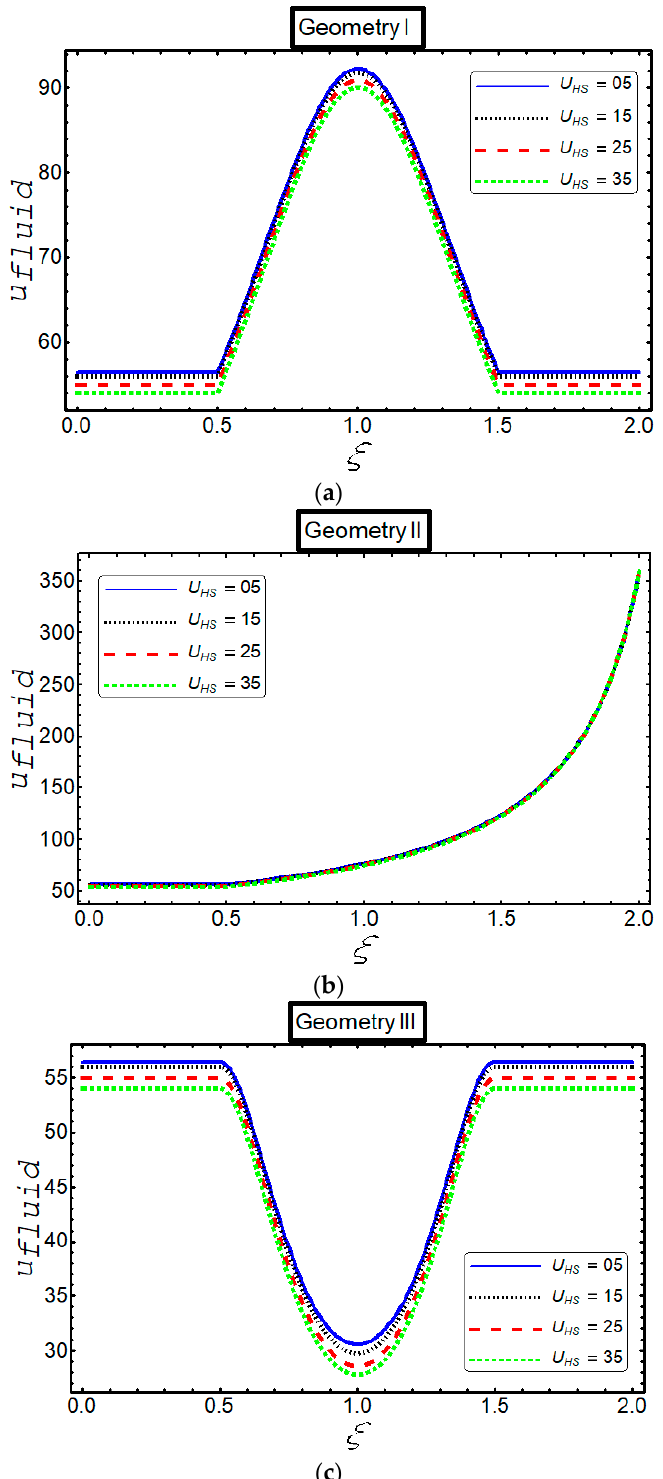
Figure 8. Velocity variation for Helmholtz–Smoluchowski velocity.